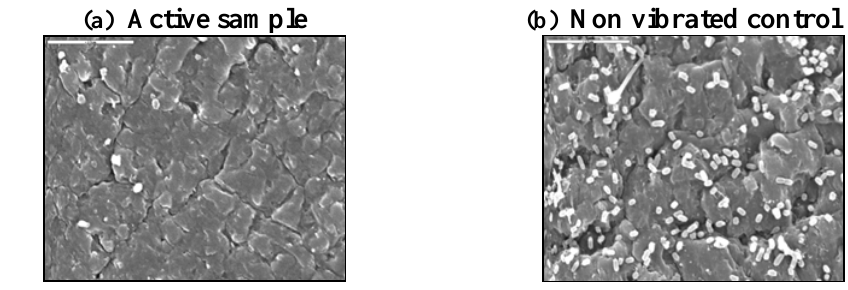
Figure 1 . Effects of low levels of acoustic energy on bacterial attachment and biofilm formation on a urinary catheter. Scanning electron microscopic analysis of a French 8 urinary catheter (a) connected to a Piezo electric element emitting 0.2 mW/cm 2 of vibration energy, and (b) catheter with a non vibrating element. The catheter was immersed in a suspension of E. coli bacteria for 48